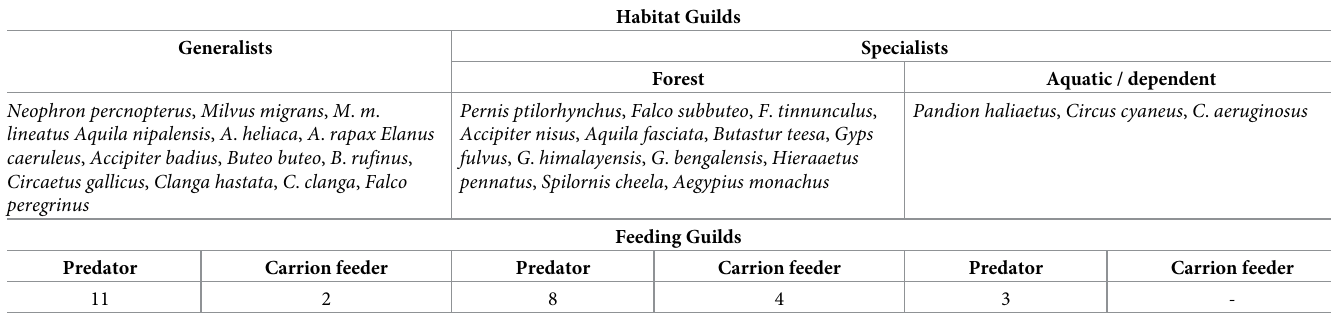
Table 2. Habitat and forging guilds of diurnal raptors in the study area.